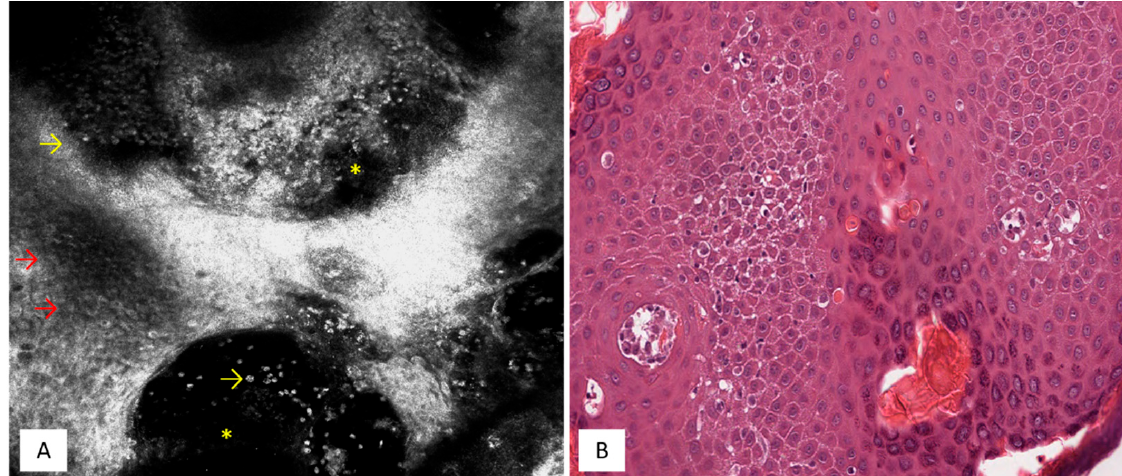
Figure 3. Stratum Spinosum. ( A ) Intraepidermal dark vesicular areas (asterisks) containing small mildly refractive cells (yellow arrows) and broadband intercellular spaces (red arrows) are seen under RCM. ( B ) RCM features correlate with spongiosis, vesicles, and mild lymphocytic exocytosis, seen on horizontal histopathology (hematoxylin and eosin: original magnification 200×).